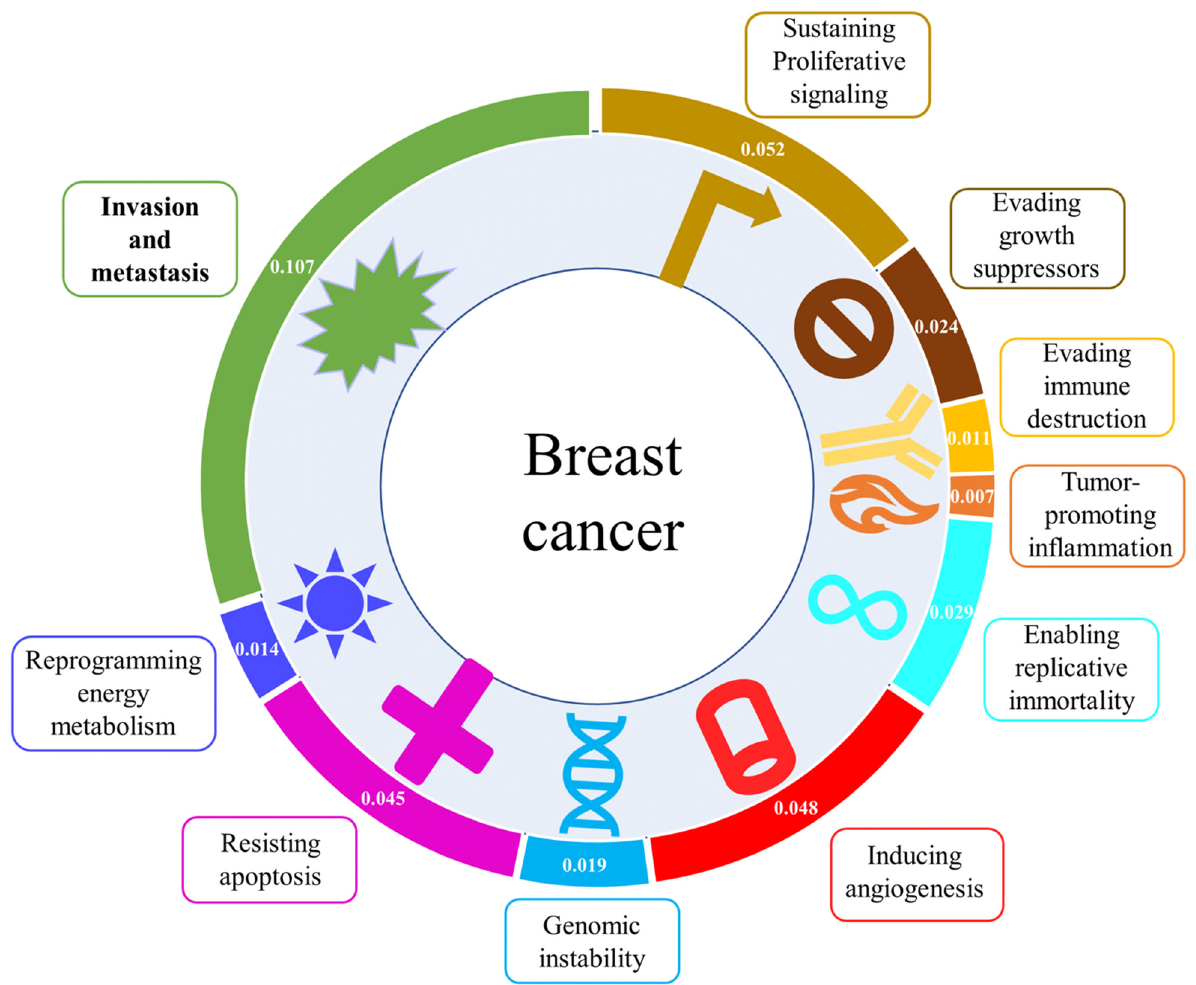
Figure 1. Outline of the ten hallmarks of cancer with PubMed association score for each hallmark keyword with breast cancer. The association score of each of the hallmarks, represented by one of the keywords: “proliferation”, “growth”, “immune”, “inflammation”, “immortality”, “angiogenesis”, “mutation”, “apoptosis”, “metabolism”, “metastasis”, AND “breast cancer” was calculated using PubMed citations. The number of citations for each hallmark with breast cancer was then divided by the number of each query term alone according to the following equation: association score = (citations of “keyword” for each hallmark AND “breast cancer”) / (citations of “keyword” for each hallmark). Note that the association score of invasion and metastasis is significantly higher than the other hallmarks, suggesting that this hallmark is highly explored and should be considered a prime therapeutic target.